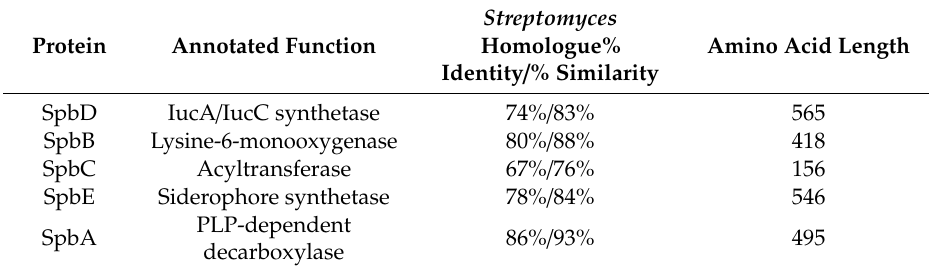
Protein Annotated Function